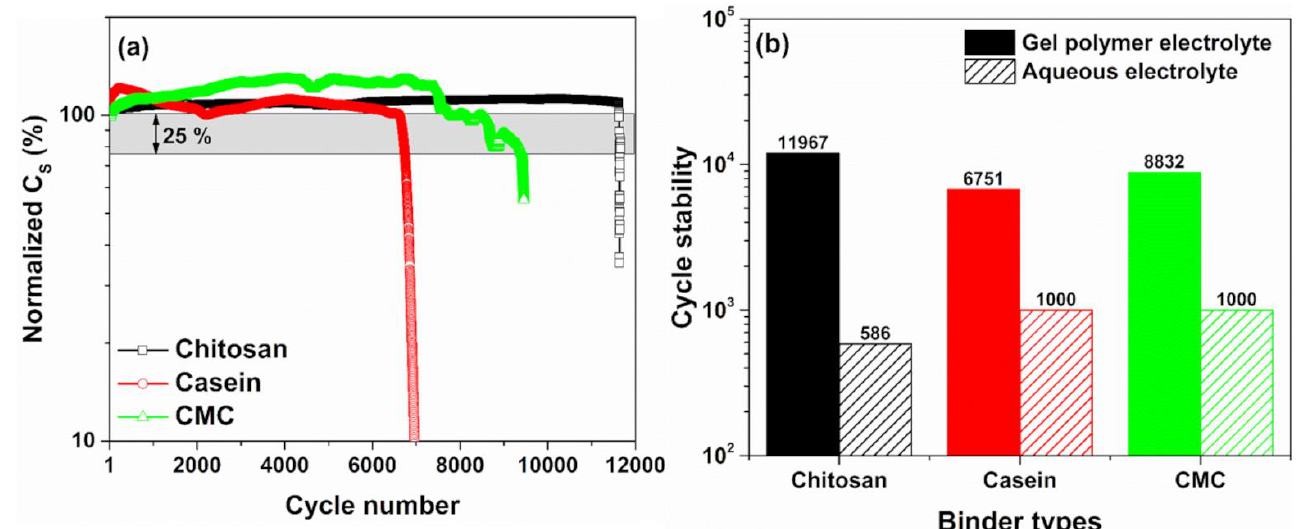
Figure 6. ( a ) Cycles stability of the SC-based gel polymer electrolyte 2 M of NaCl performed with CV cycles at 300 mV/s in the voltage range between 0 and 1 V; ( b ) comparison of the endurance test for the devices based on the hydrogel and the reference liquid electrolyte as a function of the binder types.